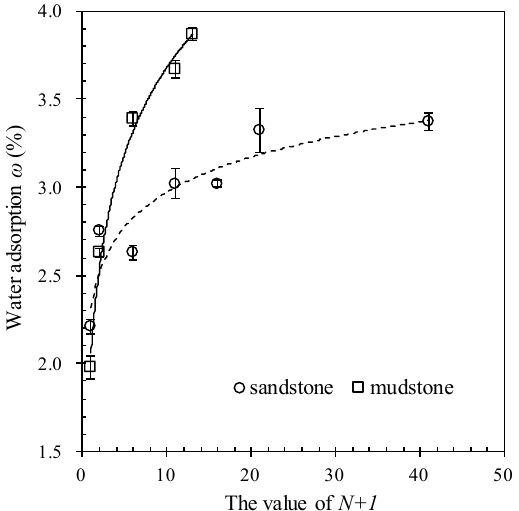
Figure 5. Relationship between the water adsorption and the value of N + 1.